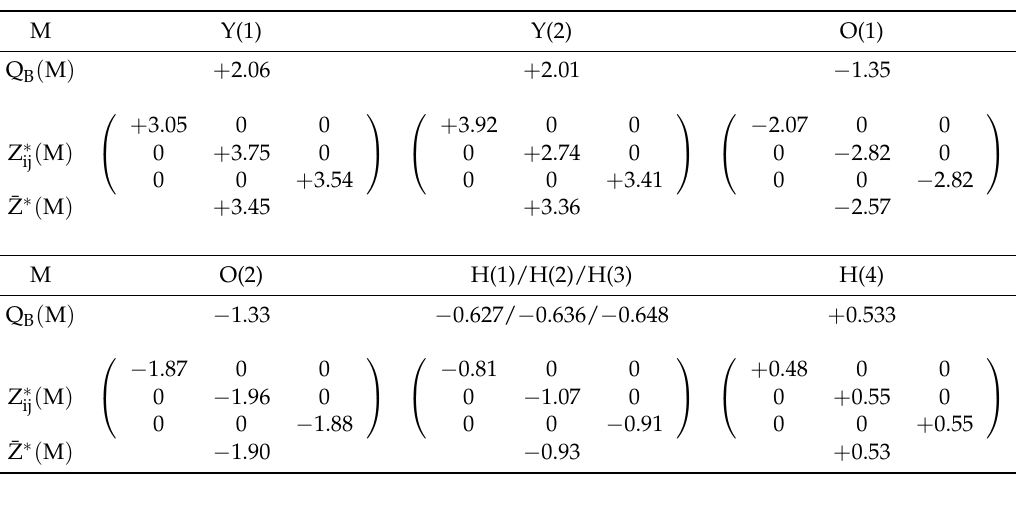
Table 4. Characteristics of ions in Y 2 H 3 O(OH) in terms of effective charges (in units of | e | ): The quantities Q B ( M ) describe the Bader effective charges. Z ∗ charges. The quantity ¯Z ∗ ( M ) corresponds to the average of the principal values over crystal axes. The proton occupying the H(4) position exhibits a positive effective charge of + 0.53 | e | , typical for charge distribution in OH –